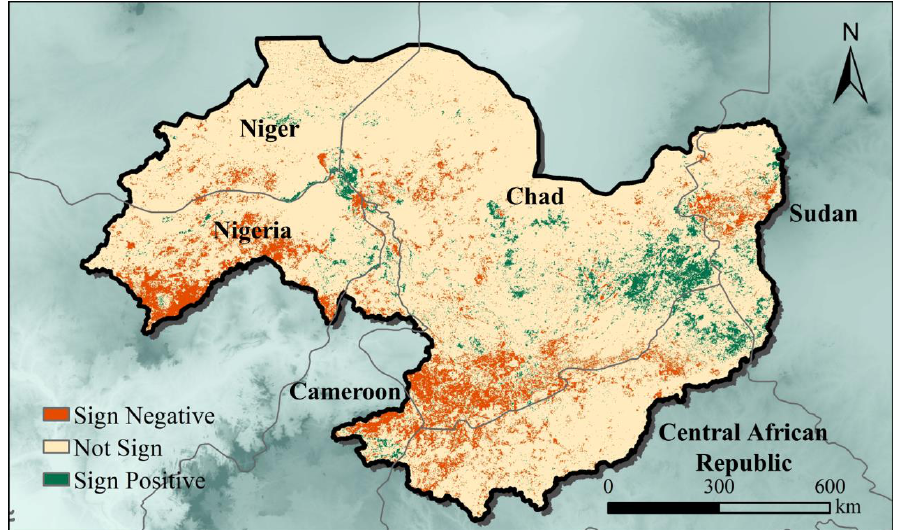
Figure 4. Spatial distribution of NPP trends in the CLCB from 2001 to 2020. The significance of each pixel is at the 5% level.